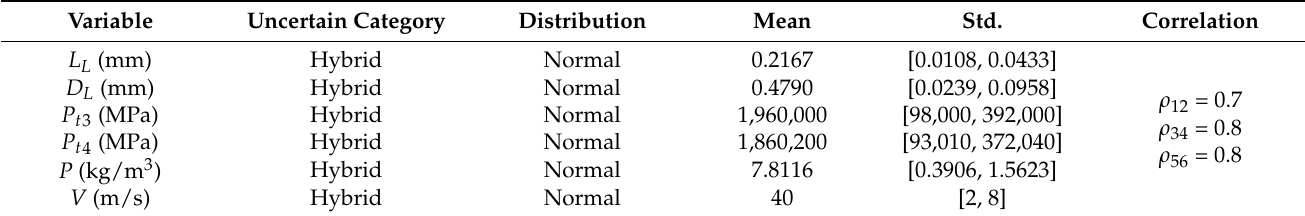
Table 3. Uncertain variable distribution types and parameters for OTDF.